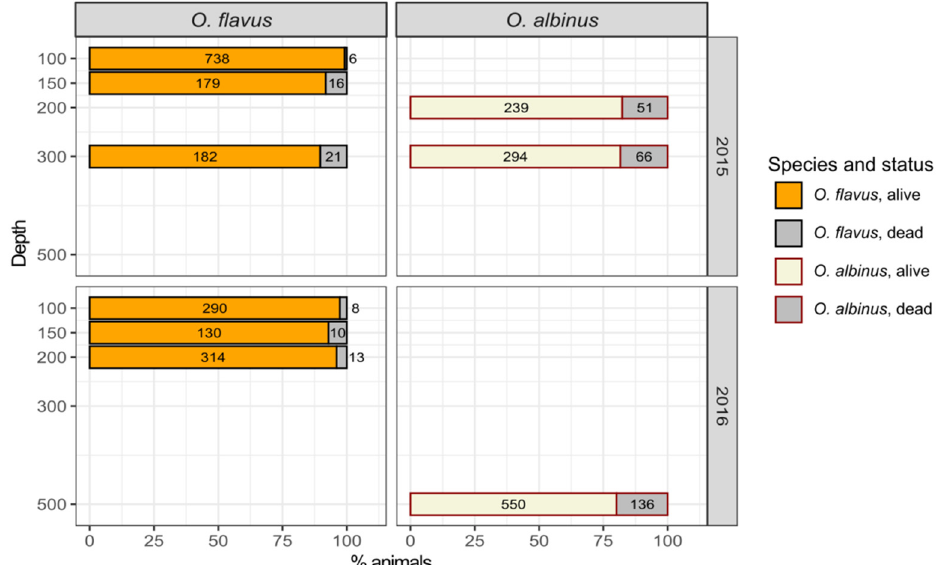
Figure 4. Survival of O. flavus and O. albinus after long-term acclimation to laboratory conditions at atmospheric pressure. In the 1st sampling campaign, the acclimation lasted 9–12 days for both species; in the 2nd sampling campaign, it lasted 18–27 days for O. flavus and 13–16 days for O. albinus .